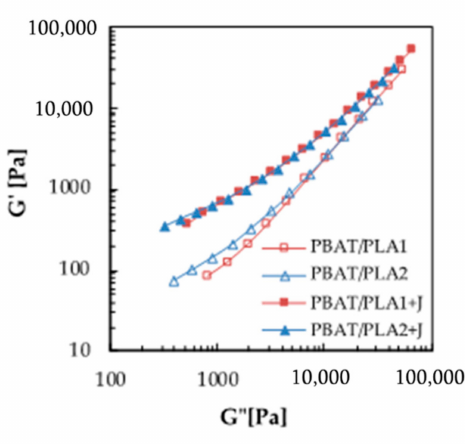
Figure 3. Plot of G’ versus G” for the blended